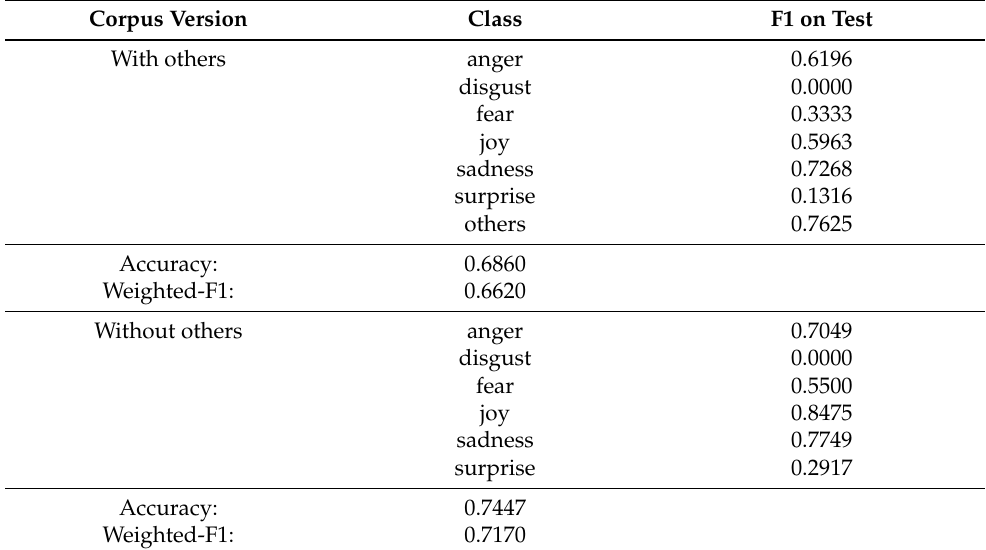
Table 5. Results on the test set training with the EmoEvent + SemEval corpus, with and without the others class. Corpus Version Class F1 on Test With others anger